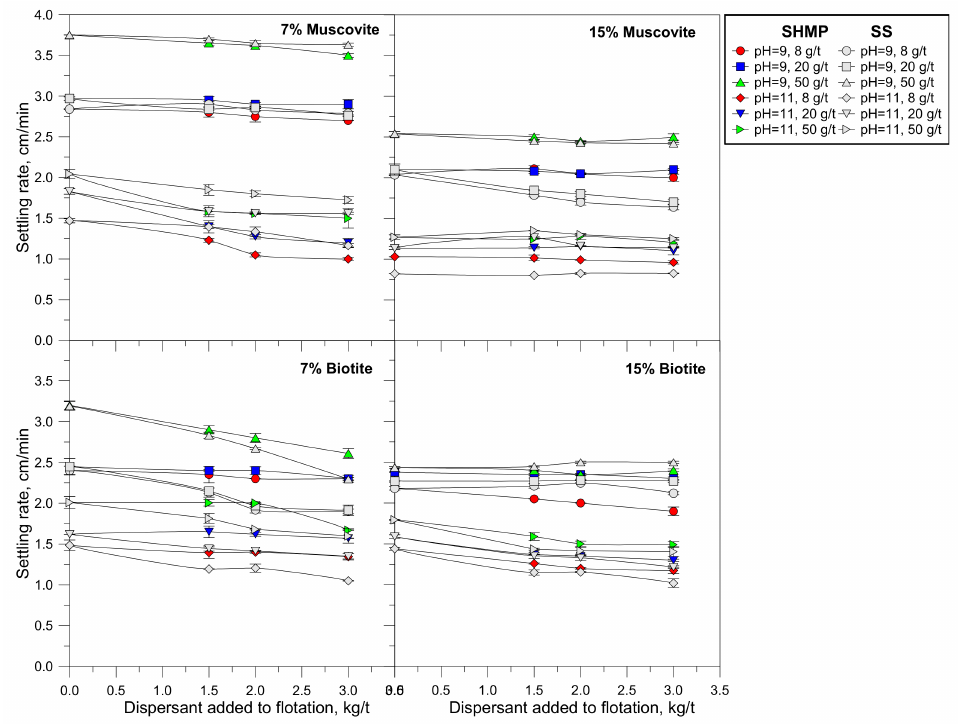
Figure 8. Settling rates of flotation tailings in seawater at pH 9 and 11 as a function of dispersant dosage in flotation (SHMP, SS), and two muscovite and biotite